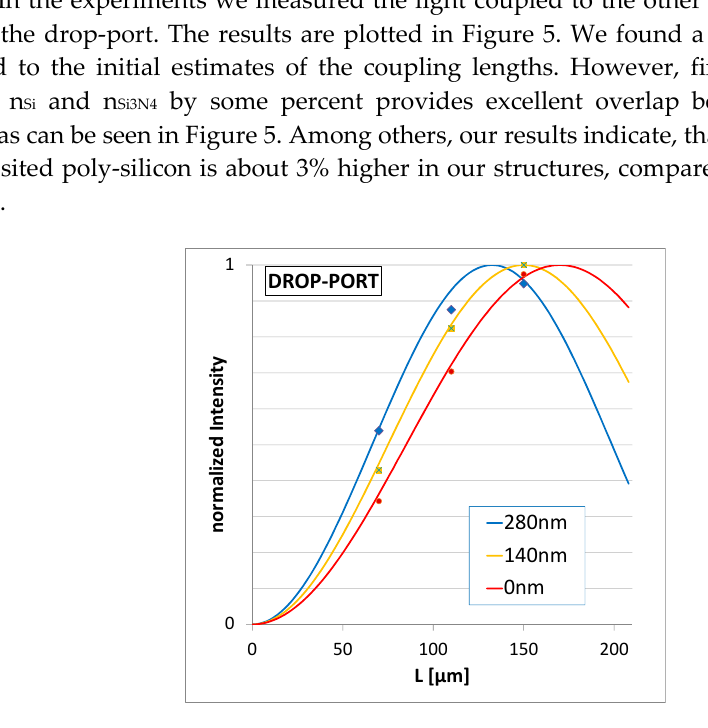
Figure 5. Comparison of simulation with experimental results. The curves show the simulated relative intensities at the through-port as a function of propagation length for three different layer-thicknesses of Si 3 N 4 . The markers show the experimental results measured on structures with interaction lengths of 70, 110, and 150 µm and different thickness of the Si3N4 layer. The values for the refractive indices of Si and Si 3 N 4 used in the simulations, were n Si = 3.53 and n Si3N4 = 1.92